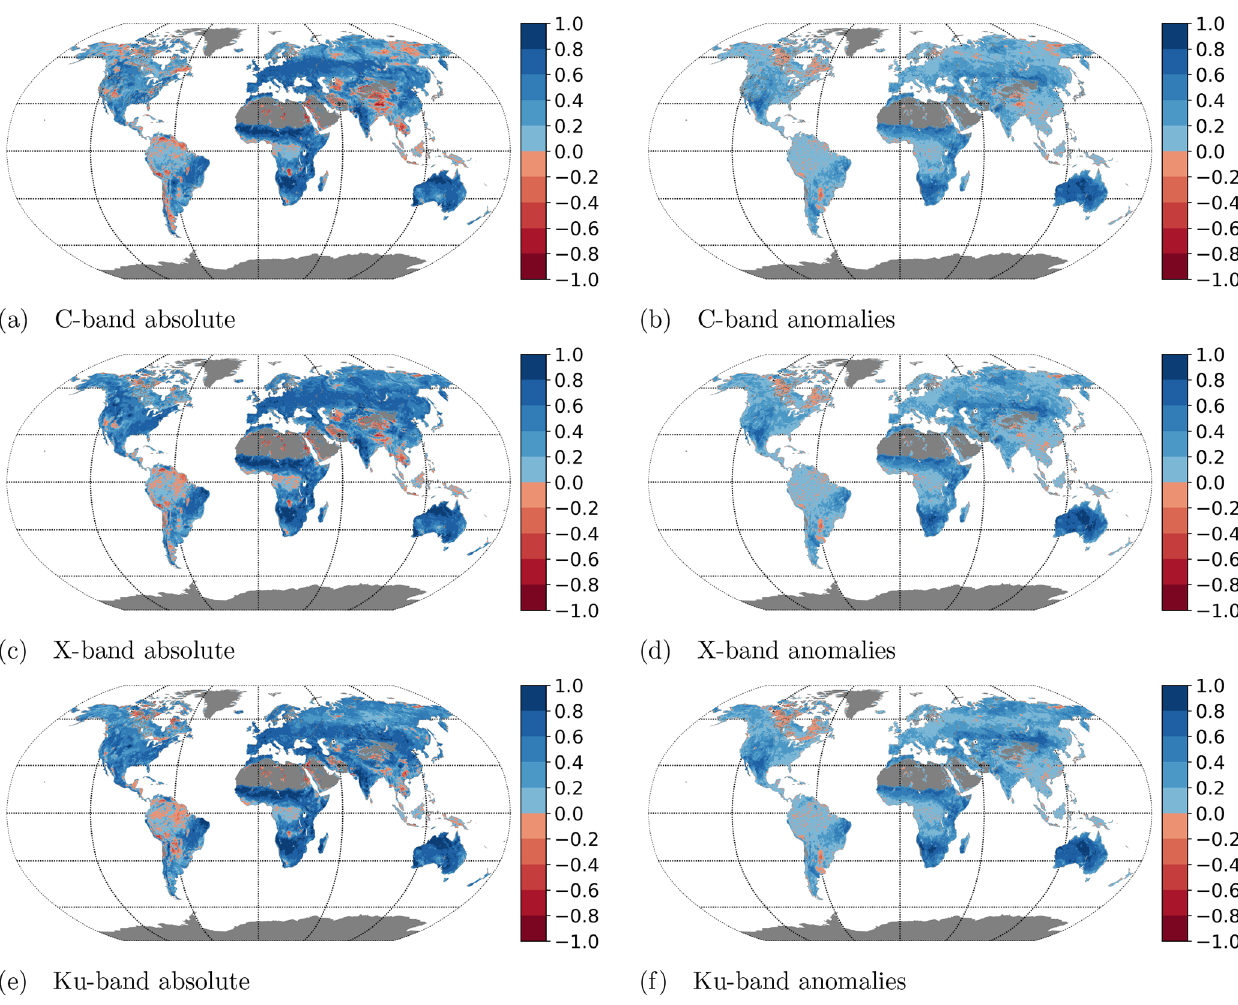
Figure 11. Spearman correlation coefficient between VODCA VOD and MODIS LAI for each band. Panels (a, c, e) show the correlation for the absolute signal, and (b, d, f) for the anomalies from the long-term VOD